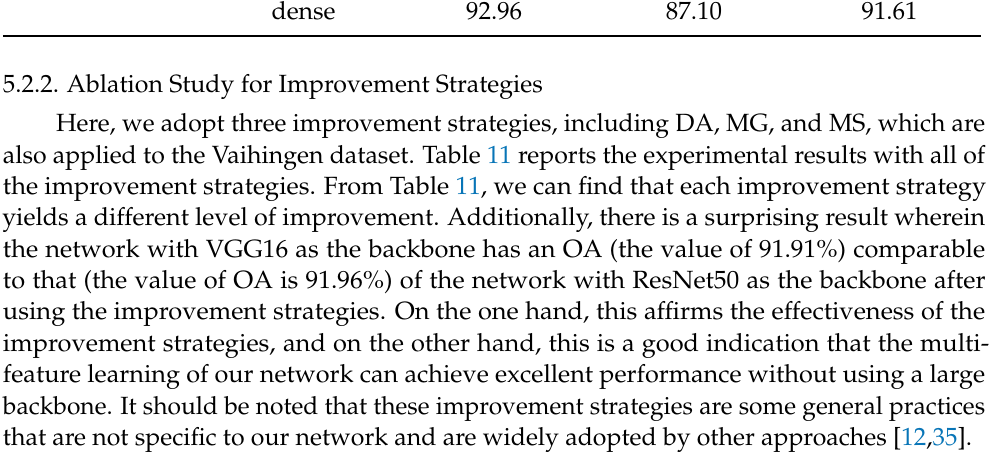
Table 11. Performance comparison between different improvement strategies on Potsdam dataset. Backbone DA MG MS Imp. Surf. Building Low